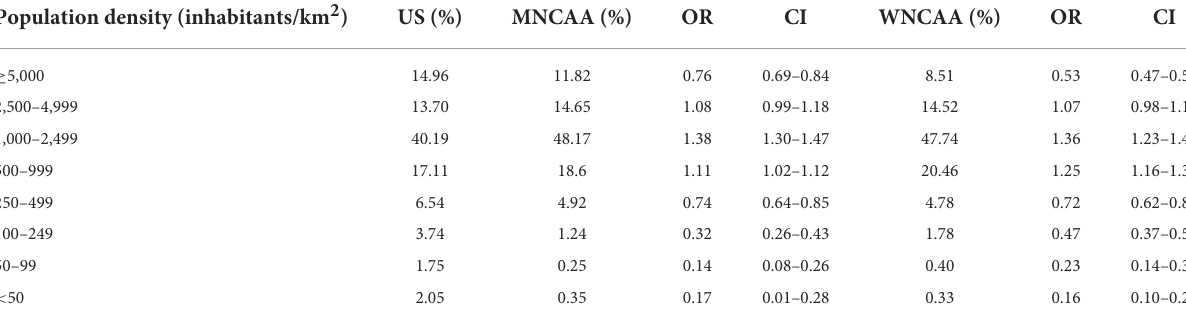
TABLE 2 Odds ratios (ORs) and confidence intervals (CIs) across population density categories for collegiate athletes. Population density (inhabitants/km 2 )